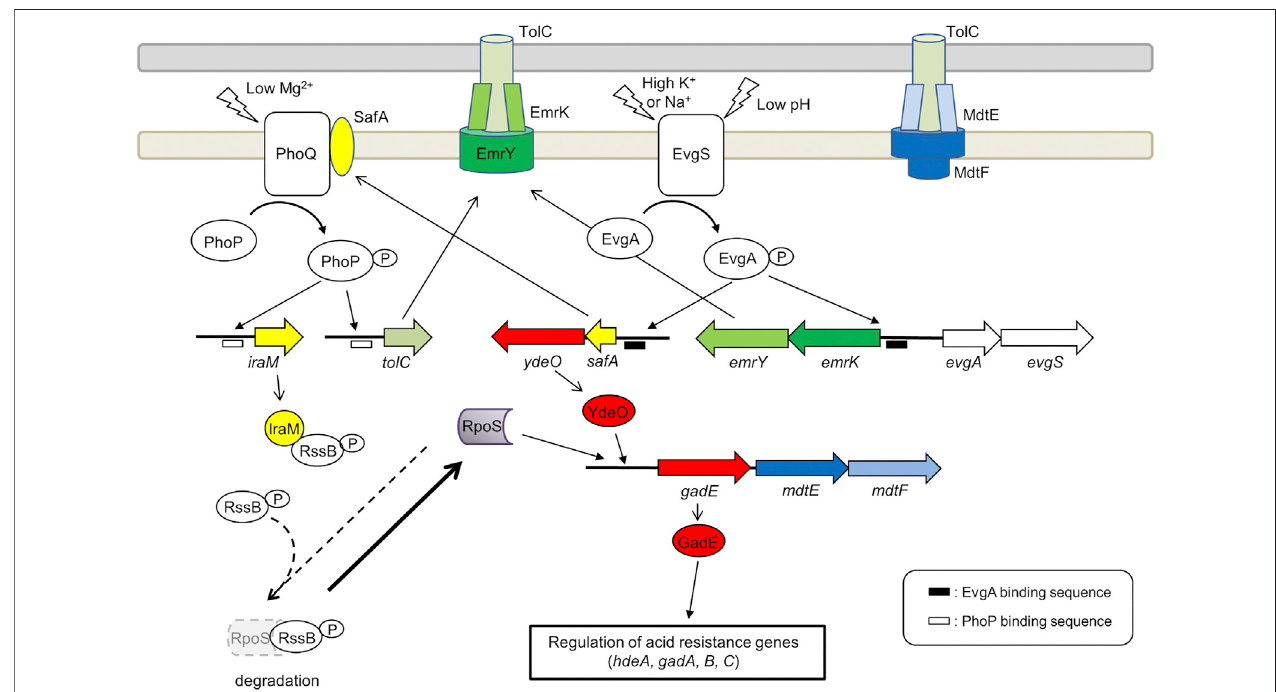
FIGURE 3 | Role of the EvgA/EvgS two component system in the activation of MDR EP encoding genes emrKY and mdtEF . The fi gure shows the EvgA-YdeO- GadE cascade and the SafA-PhoQ/PhoP-IraM-RpoS network in E. coli. The genes are highly conserved between S. fl exneri M90T and E. coli MG1655 (the amino acid sequence homology is 98 – 100%), except iraM , mdtE, and mdtF . The iraM gene shows 61.7% amino acid homology in S. fl exneri M90T, but has 93.5% amino acid homologyin S.sonnei .Although mdtE and mdtF aredisruptedin S. fl exneri ,theyareconservedin S.dysenteriae , S.boydii ,and S.sonnei .EvgA-P,PhoP-P,YdeO, RpoS, and GadE positively regulate the target genes (indicated by arrows). EvgA-P and PhoP-P also induce the expression of gadE-mdtEF by directly binding to the gadE